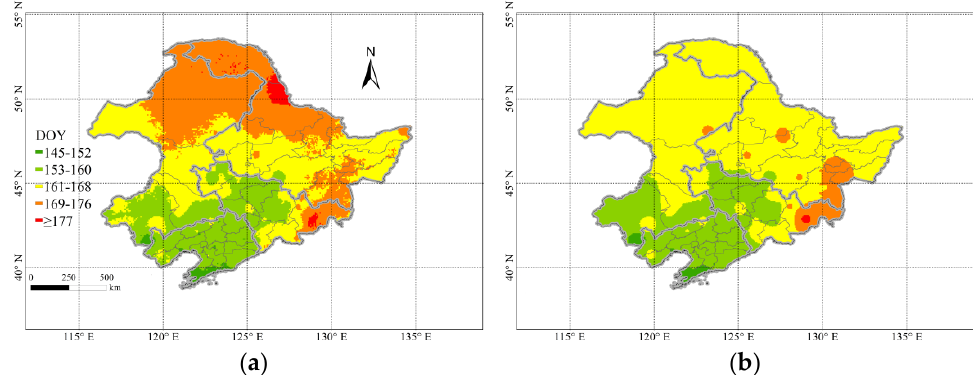
Figure 6. Seven-leaf stage (V7) of maize in Northeast China (( a ) fusion data; ( b ) original data).